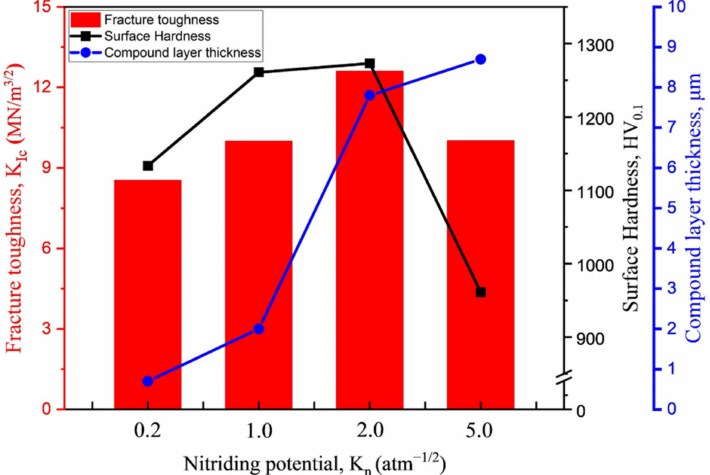
Figure 6. Fracture toughness of the nitrided AISI D2 specimens compared with the surface hardness and compound layer thickness as a function of the nitriding potentials.